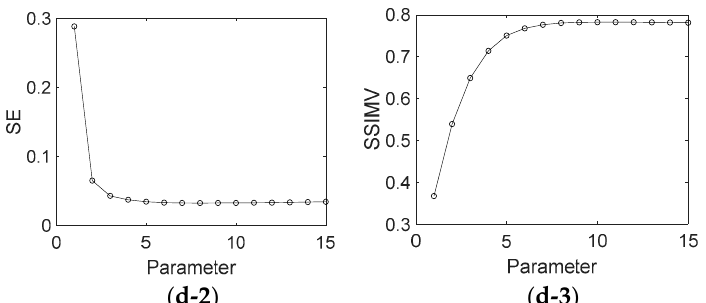
Figure 7. CrossUV, SE and SSIMV for Figure 2 by Fourier transform method with different parameter values. ( a-1 ) CrossUV for Figure 2a; ( a-2 ) SE for Figure 2a; ( a-3 ) SSIMV for Figure 2a; ( b-1 ) CrossUV for Figure 2b; ( b-2 ) SE for Figure 2b; ( b-3 ) SSIMV for Figure 2b. ( c-1 ) CrossUV for Figure 2c; ( c-2 ) SE for Figure 2c; ( c-3 ) SSIMV for Figure 2c; ( d-1 ) CrossUV for Figure 2d; ( d-2 ) SE for Figure 2d; ( d-3 ) SSIMV for Figure 2d.